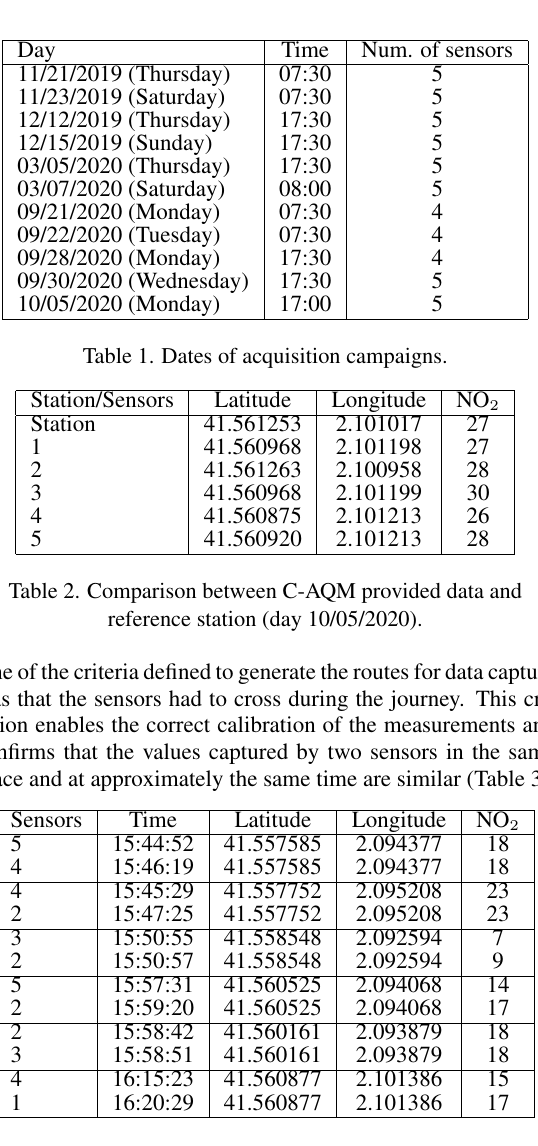
Table 3. Data from two sensors at the same coordinate and time